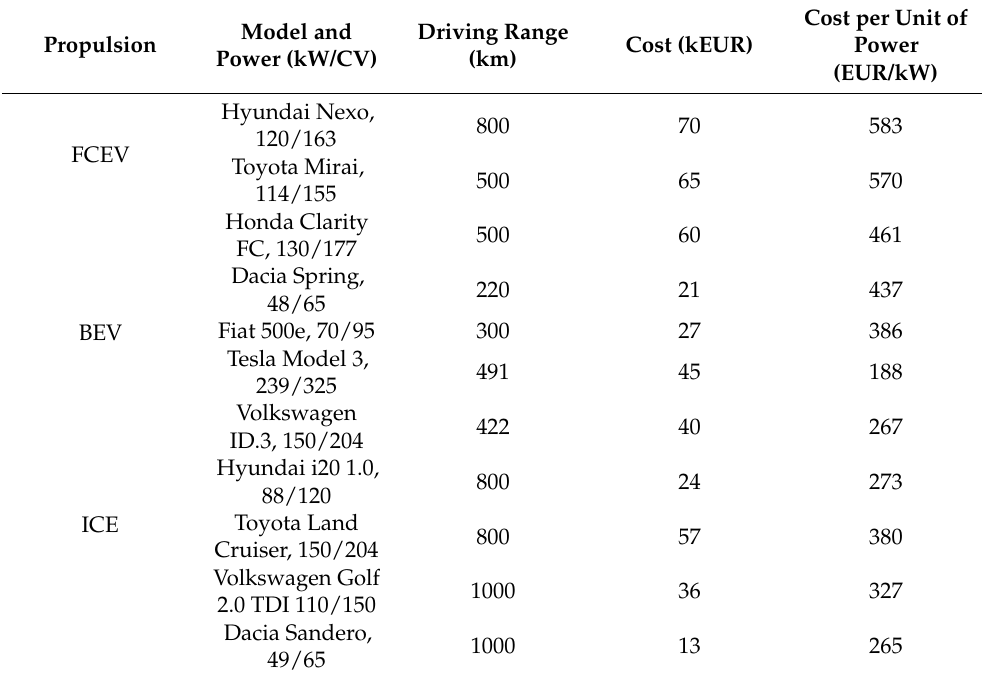
Table 3. Comparison between FCEV, BEV, and traditional cars in terms of driving range and cost (reported data available